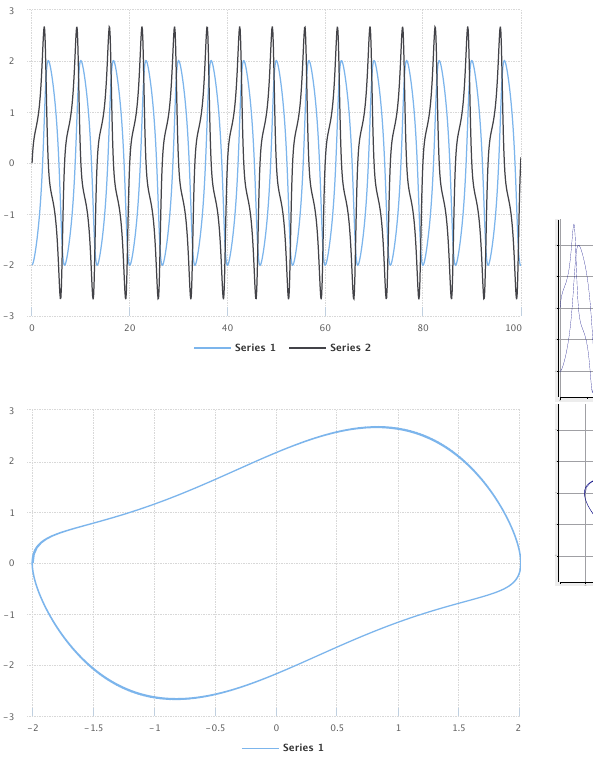
Figure A.15: The simulation result gained from the simulation description given in Listing A.9. Simulation with SED-ML web tools [2].